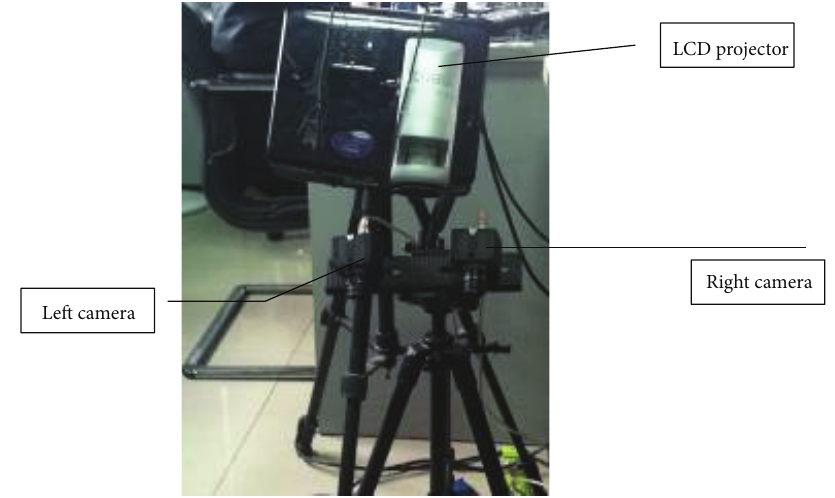
Figure 5: Hardware of binocular system.